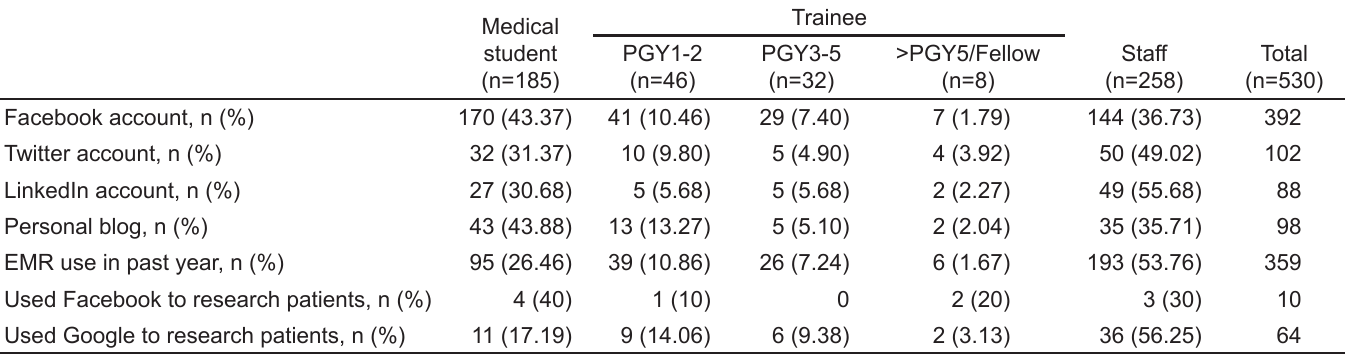
Table 2. Electronic record and social media use among survey respondents.